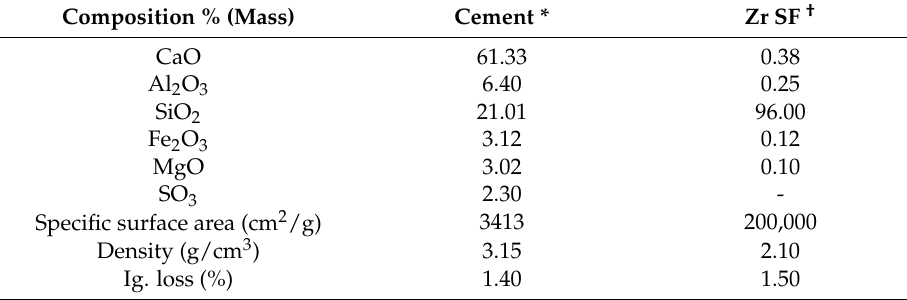
Table 2. Chemical compositions and physical properties of cementitious materials.